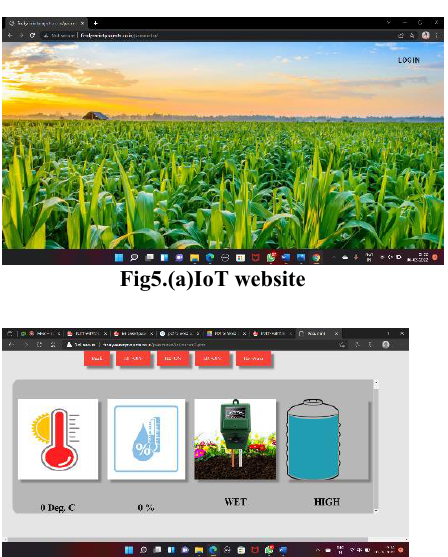
Fig5.(b)Real time data analysis